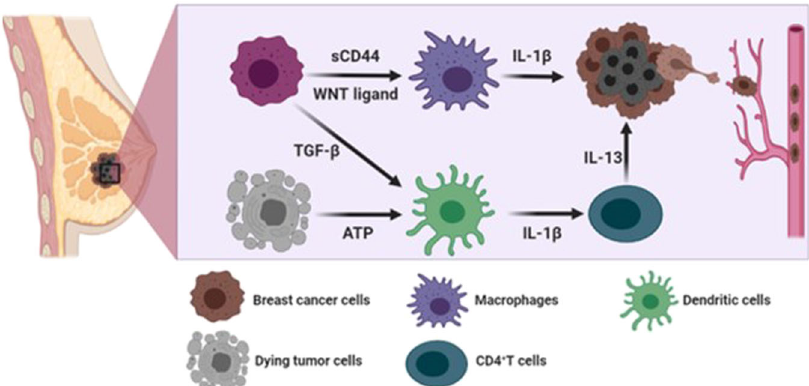
Fig. 3 Mechanisms of breast cancer progression mediated through intrinsic in fl ammasome activation. In breast tumor microenvironment, sCD44 and WNT ligand released by breast cancer cells induce secretion of IL-1 β from macrophages. In addition, TGF- β produced by breast cancer cells and ATP released from dying tumor cells stimulate IL-1 β secretion from dendritic cells, which promotes IL-13 production in CD4 + T cells. This promotes breast cancer progression and